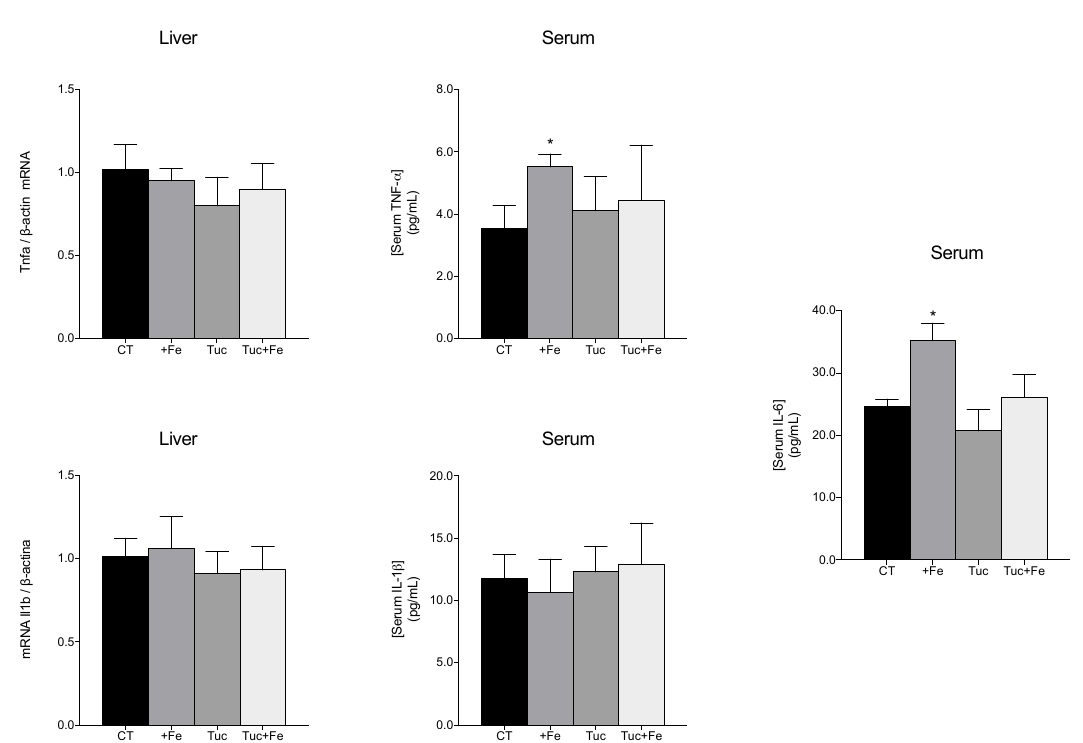
Figure 4. Quantification of the levels of hepatic interleukin-1b mRNA (Il1b) and serum protein (IL-1 β ), hepatic tumor necrosis alpha mRNA (Tnfa) and protein TNF- α and IL-6 in serum of adult rats treated for 12 weeks. Data correspond to average ± standard deviation ( n = 6). * Statistical differences compared to CT group ( p < 0.05).